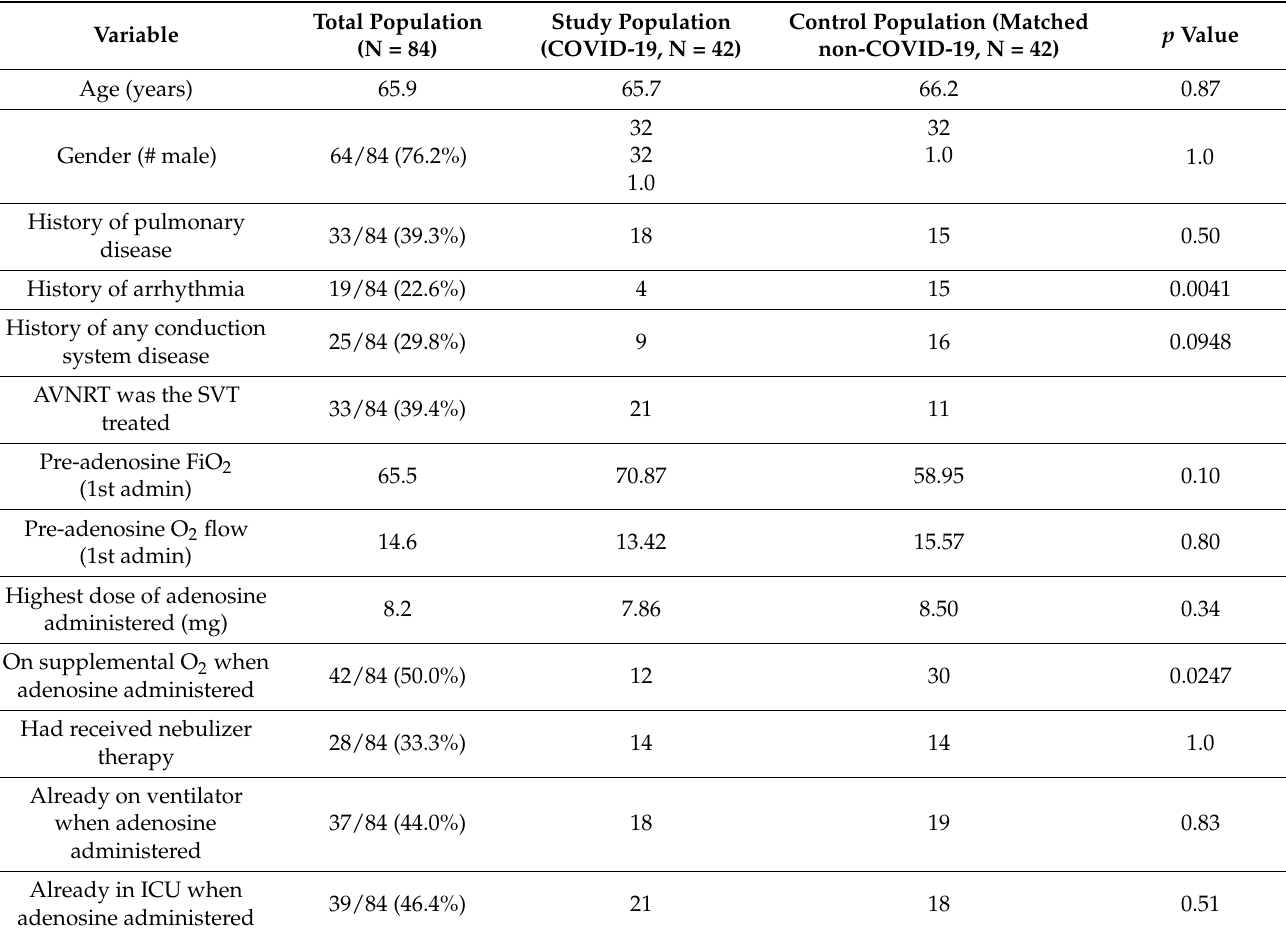
Table 1. Baseline characteristics of total population in this